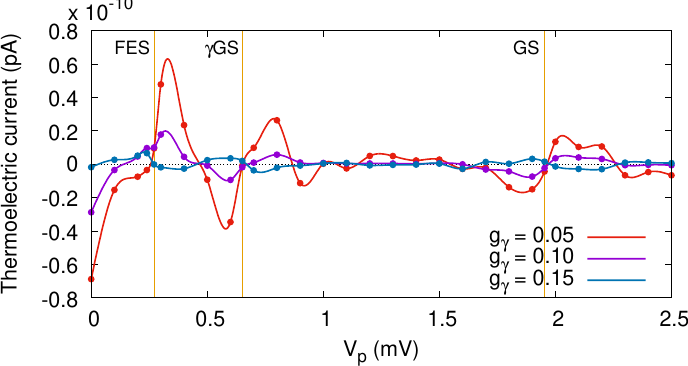
Figure 7. Thermoelectric current ( I L ) versus gate voltage for the QD system coupled to the photon cavity with g γ = 0.05 (red color), 0.10 (magenta color), and 0.15 meV (navy blue color). The photon energy is ¯ h ω γ = 1.31 meV (off-resonance regime), ¯ n R = 1, and the photon field is polarized in the direction of electron motion, the x -direction. The temperatures of the left and right leads are fixed at T L = 1.16 K and T R = 0.58 K, respectively. The chemical potential of the leads are fixed at µ L = µ R = 1.2 meV. The golden vertical lines show the resonance condition for the GS at V p = 1.95 mV, the γ GS at V p = 0.65 mV, and the FES at V p = 0.271 meV. The weak external magnetic field is B = 0.1 T, and ¯ h Ω 0 = 2.0